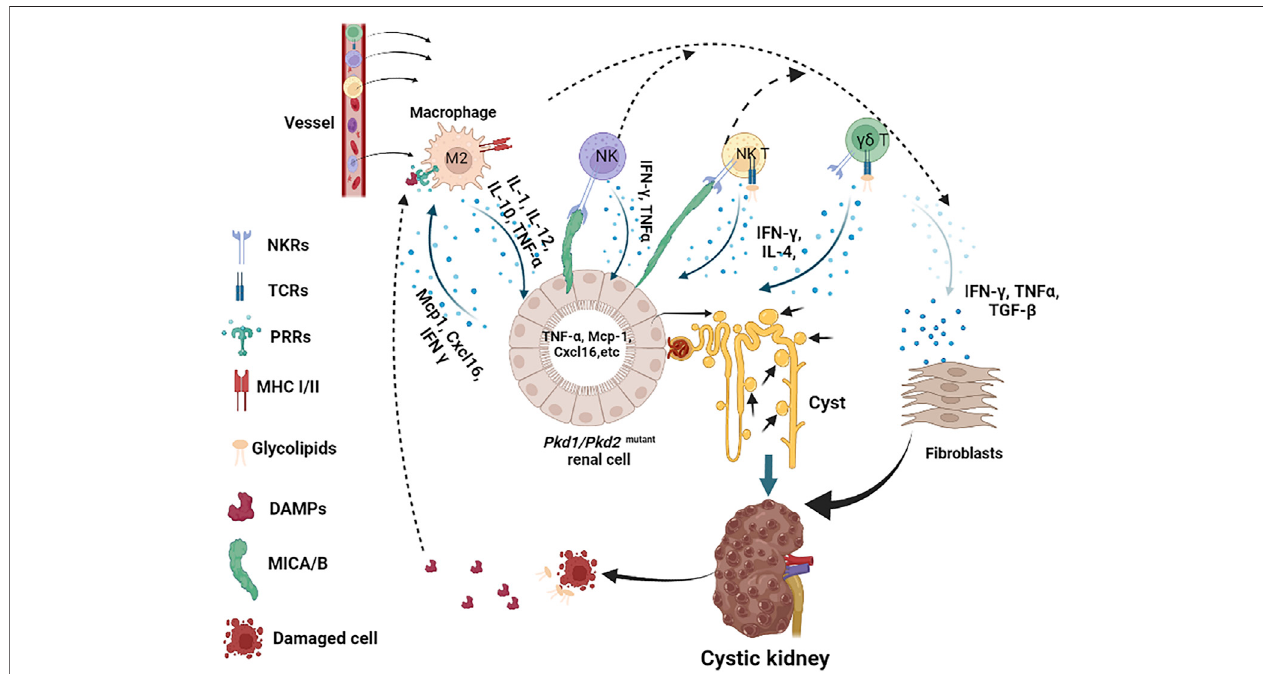
FIGURE 2 | Innate immune response cells and molecules in the pathogenesis of ADPKD. In this scheme, we describe the major innate immune cells in the pathogenesis of ADPKD, including macrophages (referred to M2), NK, NKT and γδ T cells, and the major molecules that participate in this process, including DAMPs, glycolipids, and cytokines. We indicate the main receptors on immune cells, such as MHC I/II on macrophages, TCRs and NKRs on NK, NKT and γδ T cells. Pkd1 de fi cientrenalcellsreleaseMcp-1andCxcl16,whichrecruitmacrophagestothekidney,othercytokinesalsoattractNK,NKTand γδ Tcellstoin fi ltratetokidneyas well.ActivatedmacrophagesreleaseTNF- α andothercytokinesthatstimulaterenalcellproliferationandinducestressresponse,resultingintheaccumulationofDAMPs in fl uidorintestinalorinductionofMICA/Bonsurfaceofrenalcells.UponrecognitionofDAMPsandglycolipidsreleasedbydamagedordyingcells,orMICA/Bpresented on the surface of cystic cells, activated macrophages, NK, NKT and γδ T cells produce cytokines, such as TNF- α , IFN- ɣ , and TGF- β etc, to further promote cystic renal cell proliferation or renal fi brosis in